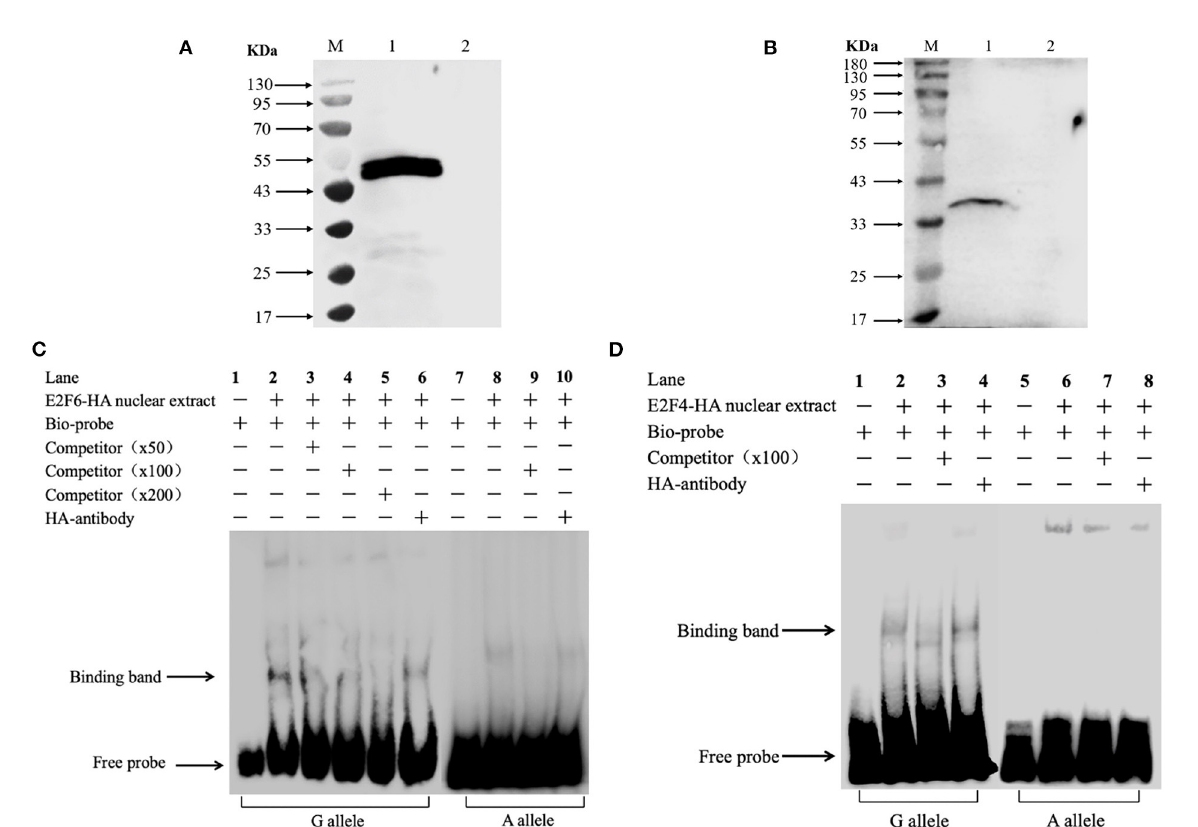
FIGURE5 In vitro analysis of the interaction between transcription factors and STAT3 gene carrying SNP1. (A) Over expression of porcine E2F4 in IPEC-J2. Lane M: marker; Lane 1: IPEC-J2 transfected with pCMA-HA-E2F4; Lane 2: IPEC-J2 transfected with pCMA-HA. (B) Over expression of porcine E2F6 in IPEC-J2. Lane M: marker; Lane 1: IPEC-J2 transfected with pCMA-HA-E2F6; Lane 2: IPEC-J2 transfected with pCMA-HA. (C) The binding of E2F4 on the promoter of STAT3 gene. (D) The binding of E2F6 on the promoter of STAT3 gene. Arrows represent the free probe and the specific band for the GG probe. Lane 1: Free probe containing the G allele is observed. Lane 2: Binding of nuclear proteins is observed with the probe containing the G allele. Lane 3: Binding was competed by unlabeled